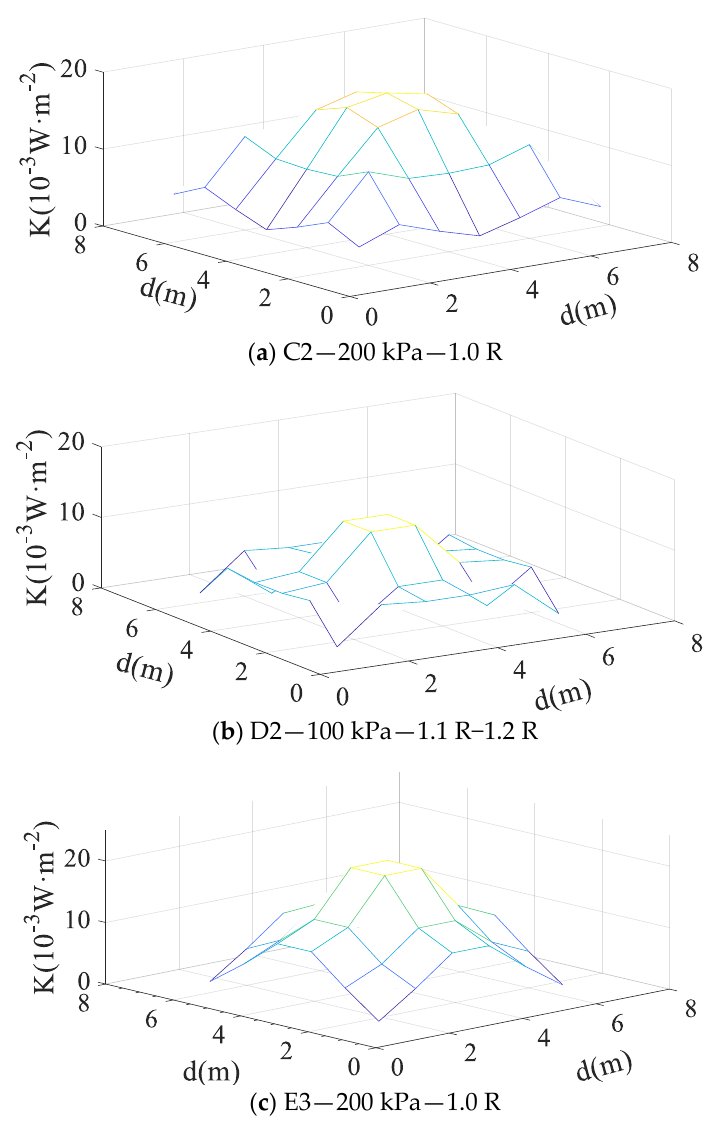
Figure 18. Distribution of kinetic energy intensity under combined sprinkler irrigation for each nozzle shape with the best uniformity coefficient. (C2 refers to the circular nozzle with a diameter of 5 mm; D2 refers to the diamond nozzle with an aspect ratio of 1.32; E3 refers to the elliptic nozzle with an aspect ratio of 2.58).